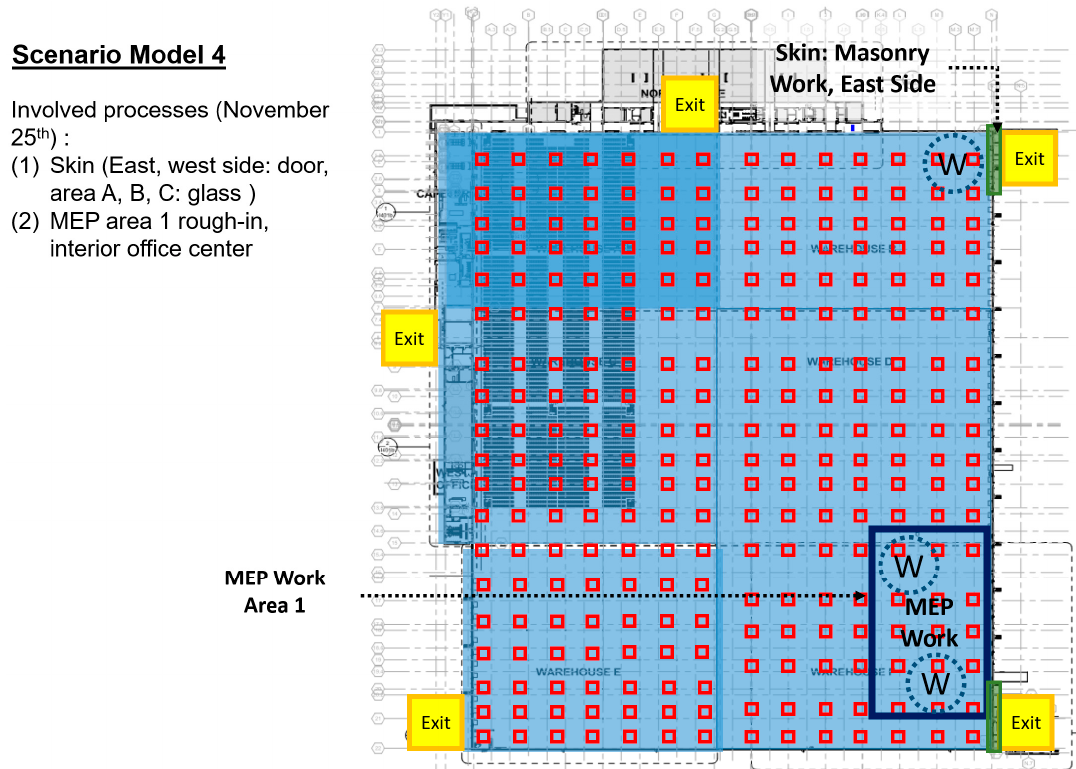
Figure 9. Scenario Model 4: Work status and site conditions.